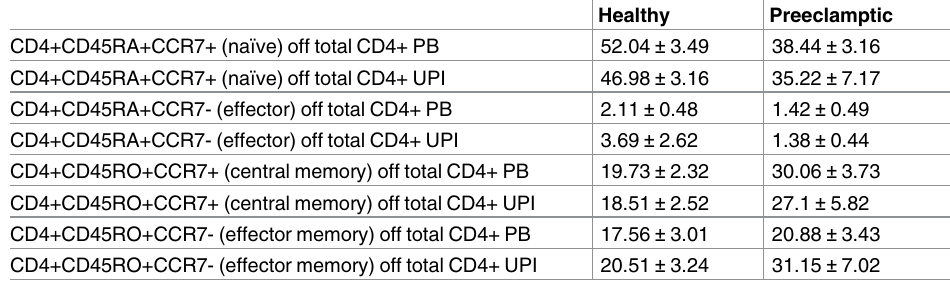
Table 5. Mean percentage +/- SEM na ï ve,effector, central memory,and effector memory CD4+ cells gated off CD4+ T cells in PB and at the UPI of healthy and preeclamptic (PE) patients, see also Fig 1A